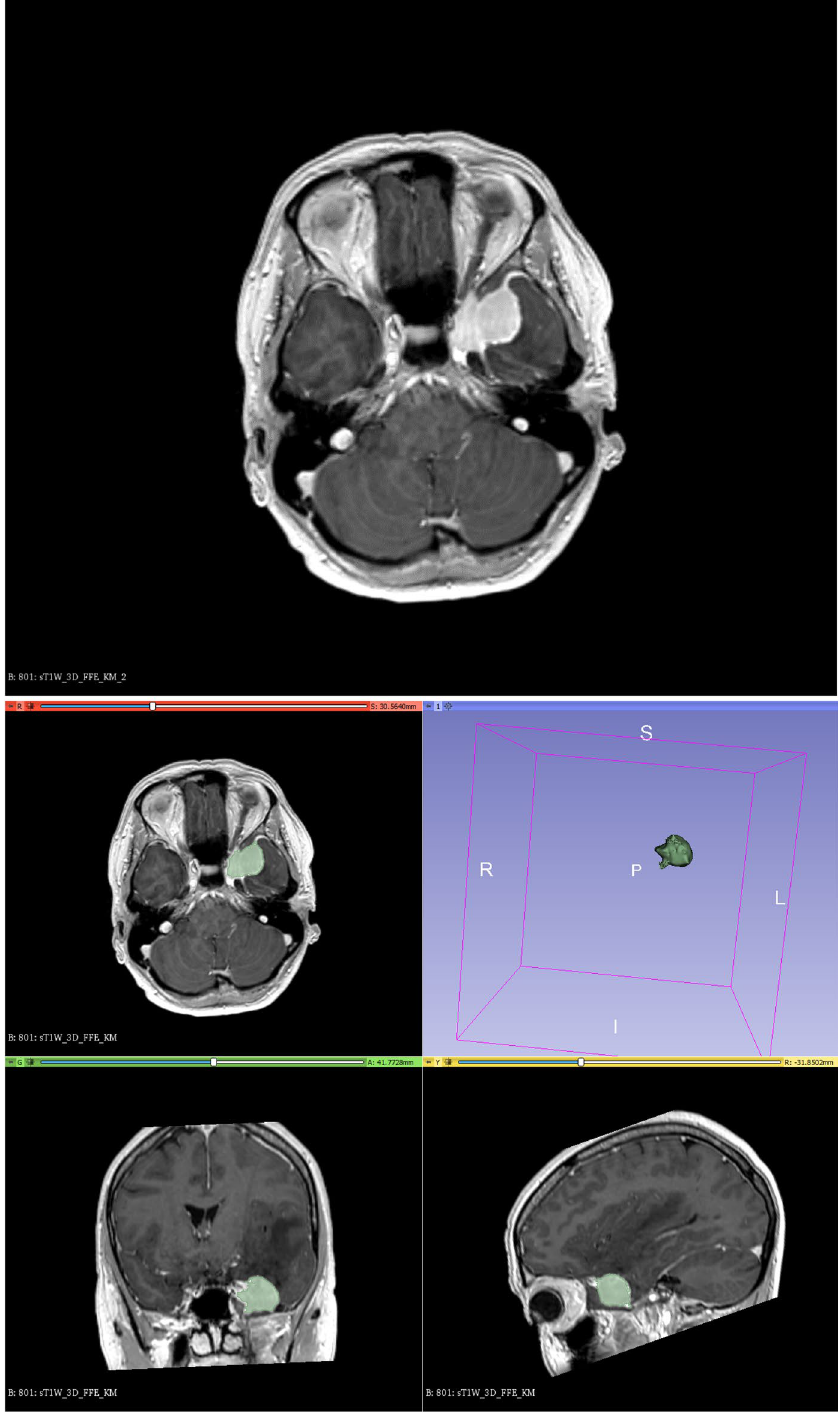
Figure 1. Meningioma of the skull base (above); semi-automatic segmentation with 3D Slicer